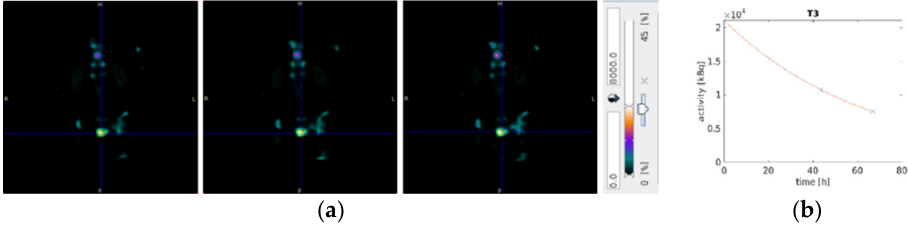
Figure 2. ( a ) Single-photon emission computed tomography (SPECT)/diagnostic computed tomog- raphy (CT) images at 24, 48 and 72 h after therapy with semi-manually placed the volume of interest (VOI) in a single bone lesion (green circle); ( b ) Mono-exponential fit curve of radioactivity over time of the lesion delineated in ( a ).